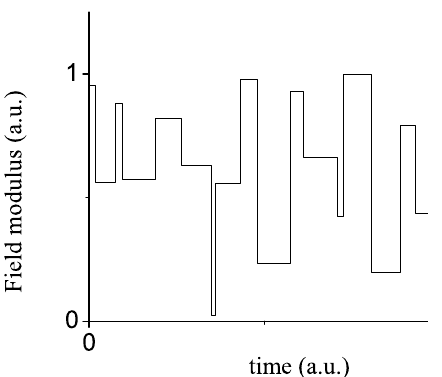
Fig. 4. Comparison of our MMM calculation (dashed line) with an ab initio simulation (solid line) |−→ inal jumping frequency v ( t E ) (dashed line). We have also plotted a